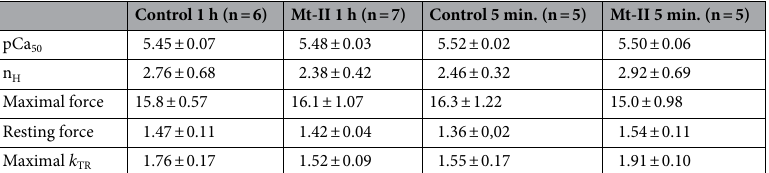
Table 1. Force parameters of skinned cardiomyocytes. pCa 50 : − LOG 10 [Ca 2+ ] at 50% of maximum force generation. n H : Hill coefficient or slope of the force–pCa relation; denotes cooperativity of force development. k TR : rate constant of isometric force redevelopment after a short period of isotonic shortening. No significant differences ( p > 0.05) were observed between control and Mt-II treated cardiomyocytes in any of the parameters